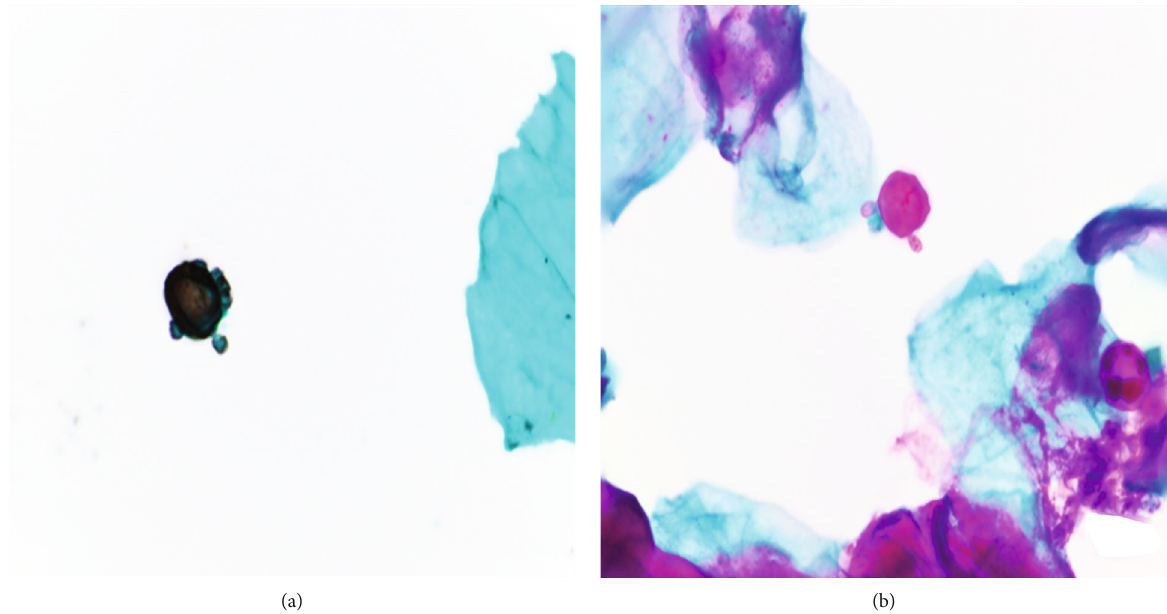
Figure 3: (a) Single large C. recurvatus fungal microorganism with multiple peripheral daughter buds. (b) Another organism with 2 peripheral daughter buds with background squamous epithelial cells (cervicovaginal cytology, ThinPrep, Gomori methenamine silver stain 1000x (a), periodic acid – Schi ff stain 1000x